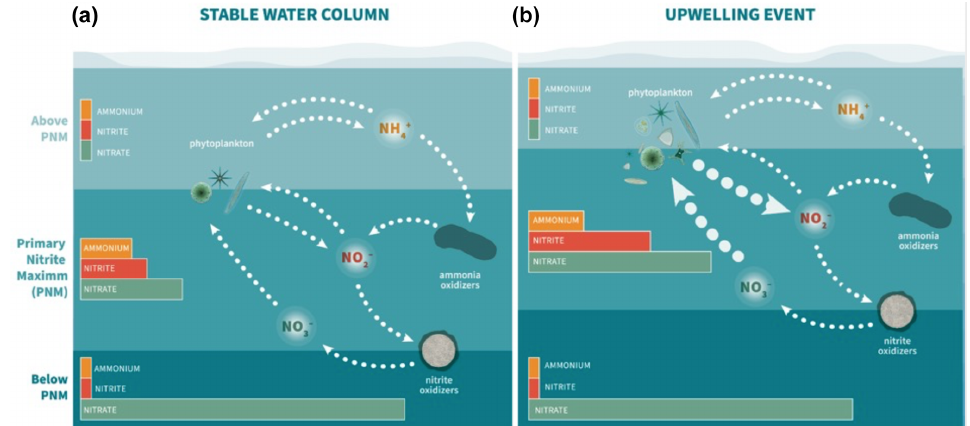
Figure 8. Schematic of nitrite cycling processes and relative DIN pools near the PNM. Panel (a) depicts the offshore conditions, and panel (b) depicts early upwelling conditions that lead to bloom initiation and larger nitrite accumulations at the